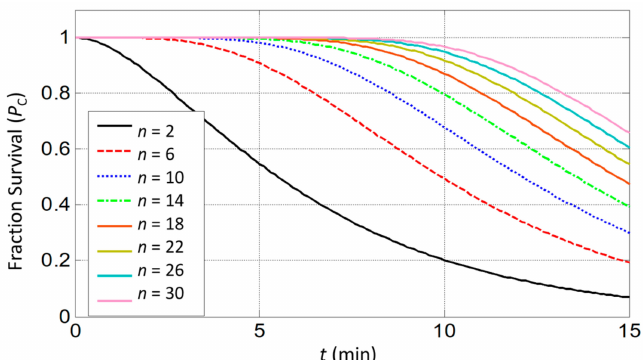
Figure 5. Estimation of cell survival rate in response to prolonged heat exposure at 44 ◦ C for molecular targets n ranging from 2 to 30.